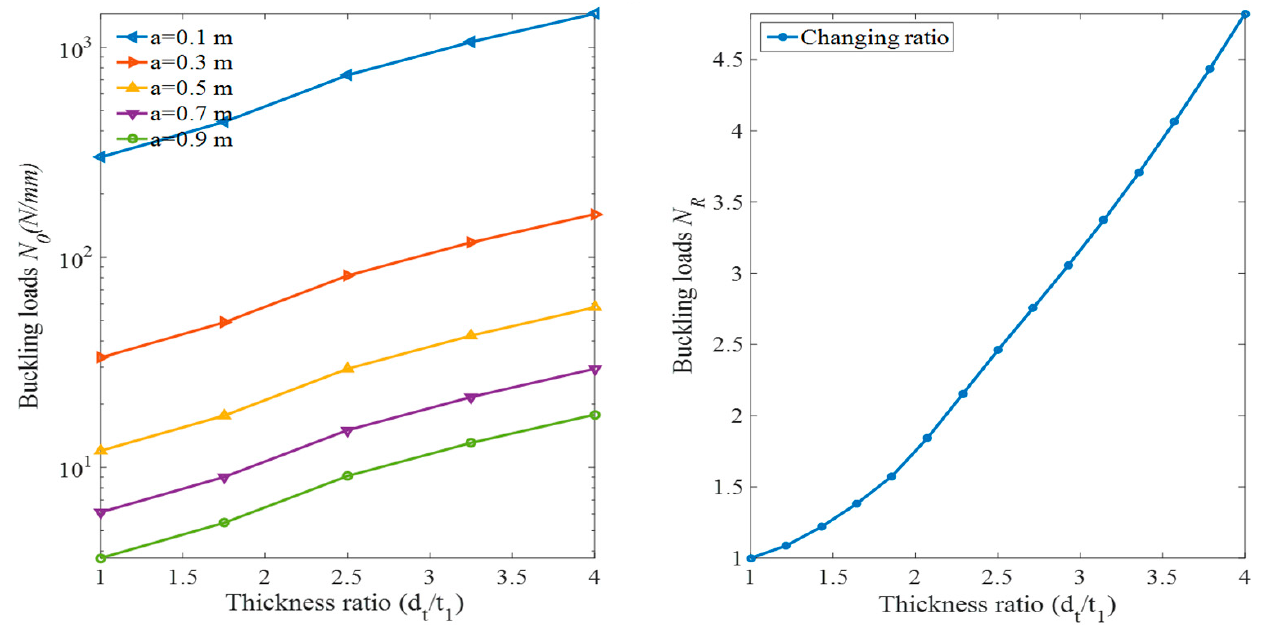
Figure 11. Buckling affected by the thickness ratio of the core layer. Table 4. Buckling loads vs. wall thickness of honeycomb.